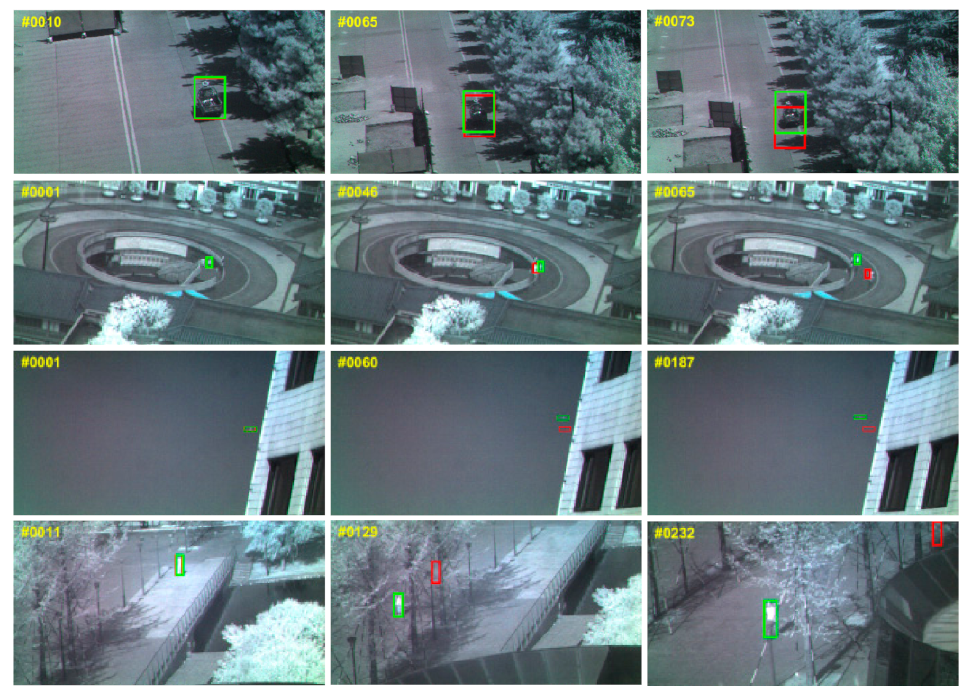
Figure 15. Qualitative results of our hyperspectral video compared to traditional video on some challenging sequences (electriccar, double5, airplane9, human4). The results of SSCF tracker and the baseline tracker are represented by green and red boxes,